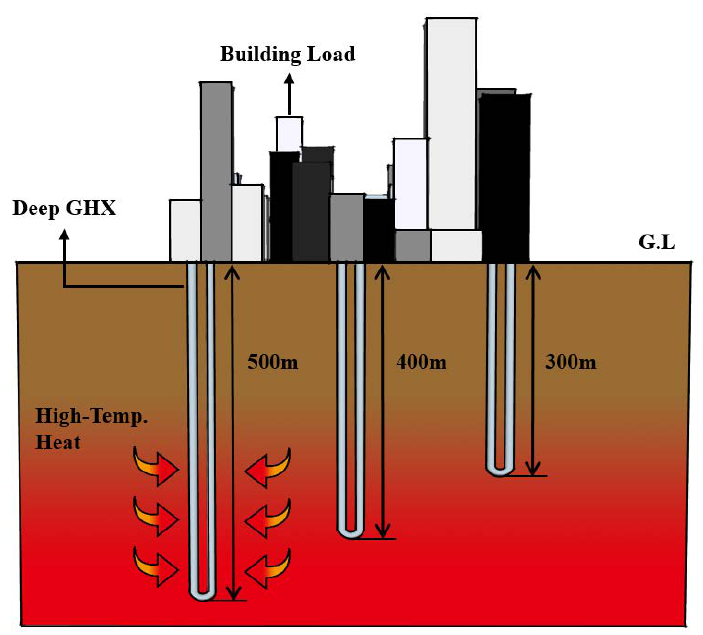
Figure 1. Concept of the deep ground heat exchanger.